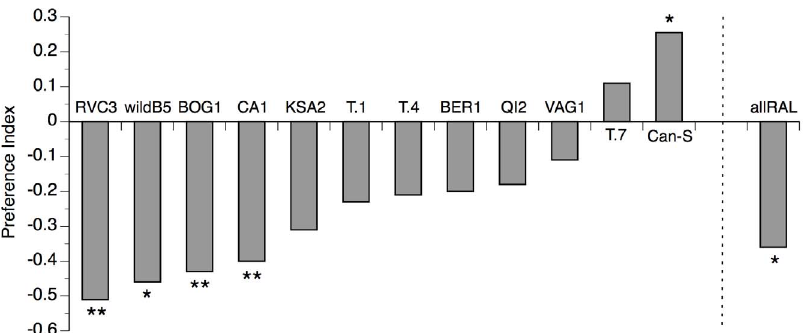
Figure 2. Preference variation in D.melanogaster males. Preference indices for D. melanogaster males from 12 inbred genotypes and one outbred population (allRAL) when allowed to choose between perfumed oe 2 females and sham-perfumed oe 2 females (lacking CHCs). The preference index is the relative advantage of oe 2 females over perfumed females, such that positive values indicate a preference for females lacking CHCs. Asterisks above the columns show preference indices that are significantly different from 0 (binomial tests: * p , 0.05; ** p , 0.01 and significant after sequential Bonferroni adjustment). N (Canton-S) =94, all other n=26–60.